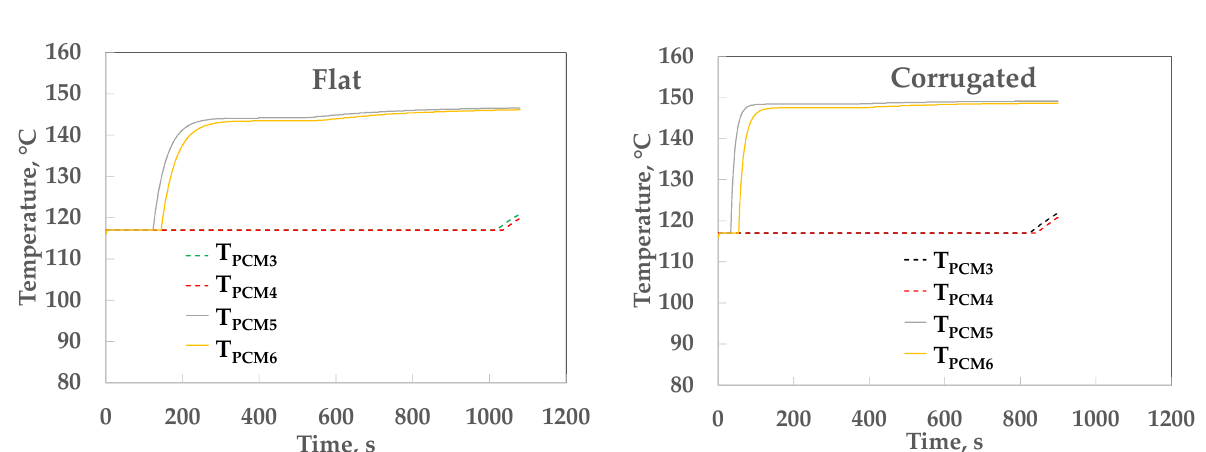
Figure 8. Temperature profiles in the side and center of the PCM.